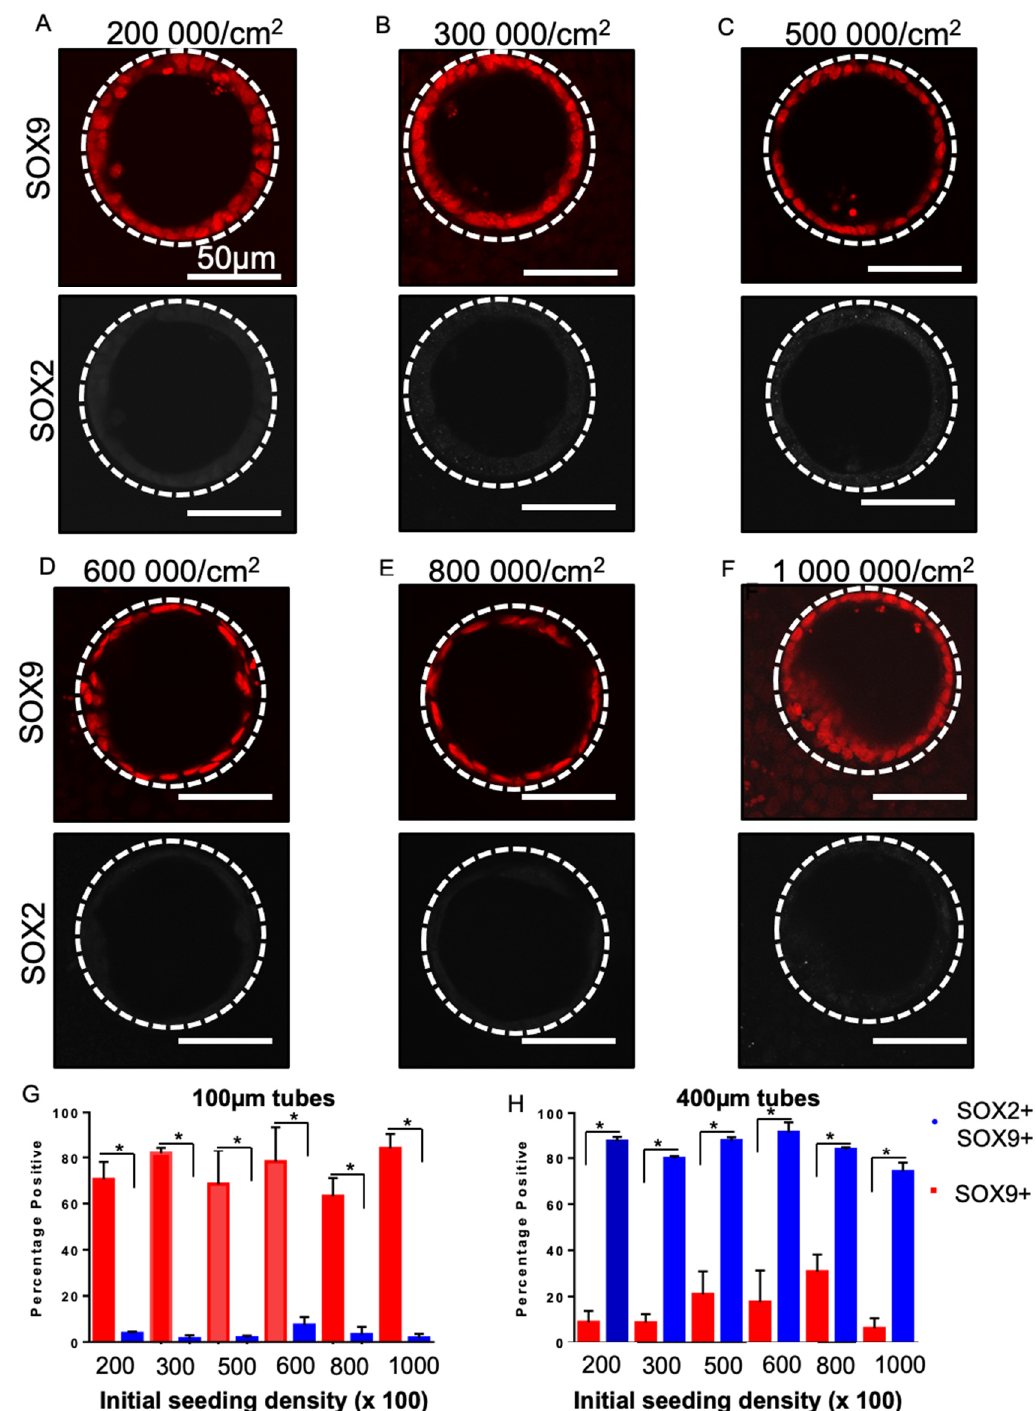
Figure 6. SOX2–SOX9 status for a range of different seeding densities. Fluorescent micrographs of day 17 lung progenitors seeded for 8 days in 100 µm tubes and stained for SOX9 (red) and SOX2 (white) are single positive for SOX9 in 200,000 cells/cm 2 ( A ), 300,000 cells/cm 2 ( B ), 500,000 cells/cm 2 ( C ), 600,000 cells/cm 2 ( D ), 800,000 cells/cm 2 ( E ), 1,000,000 cells/cm 2 ( F ). Bar charts showing quantification of the percentage of SOX9 + cells and the percentage of SOX9 + SOX2 + cells in 100 µm tubes ( G ) and 1400 µm tubes ( H ) for a range of seeding densities. A significant increase in SOX9 single positive cells and a significant decrease in SOX2 + SOX9 + was observed at all densities in 100-micron diameter tubes; * p < 0.05. Bar, 50 µm; the dotted white line approximates the PDMS border; n = 3.